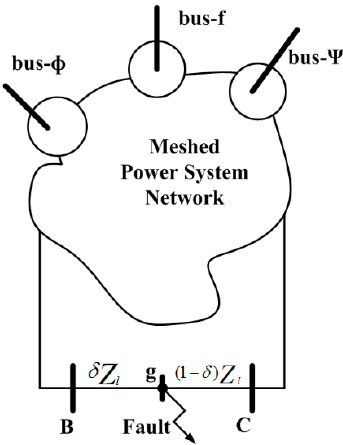
ψ . Figure 3. Short-circuit faults in line B-C and perceptive P-Q bus ψ